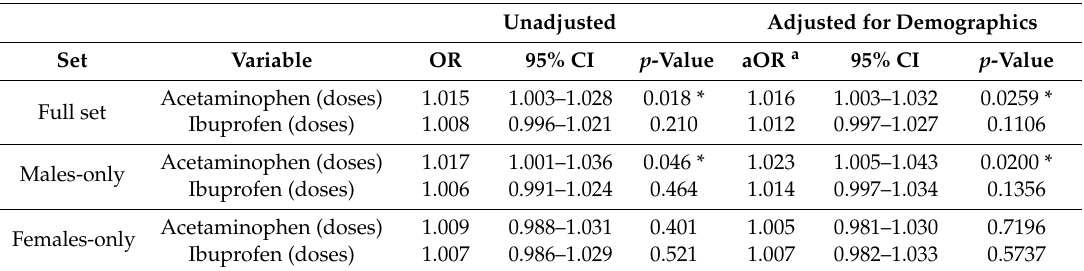
Table 3. Gender-specific ORs and aORs for scaled